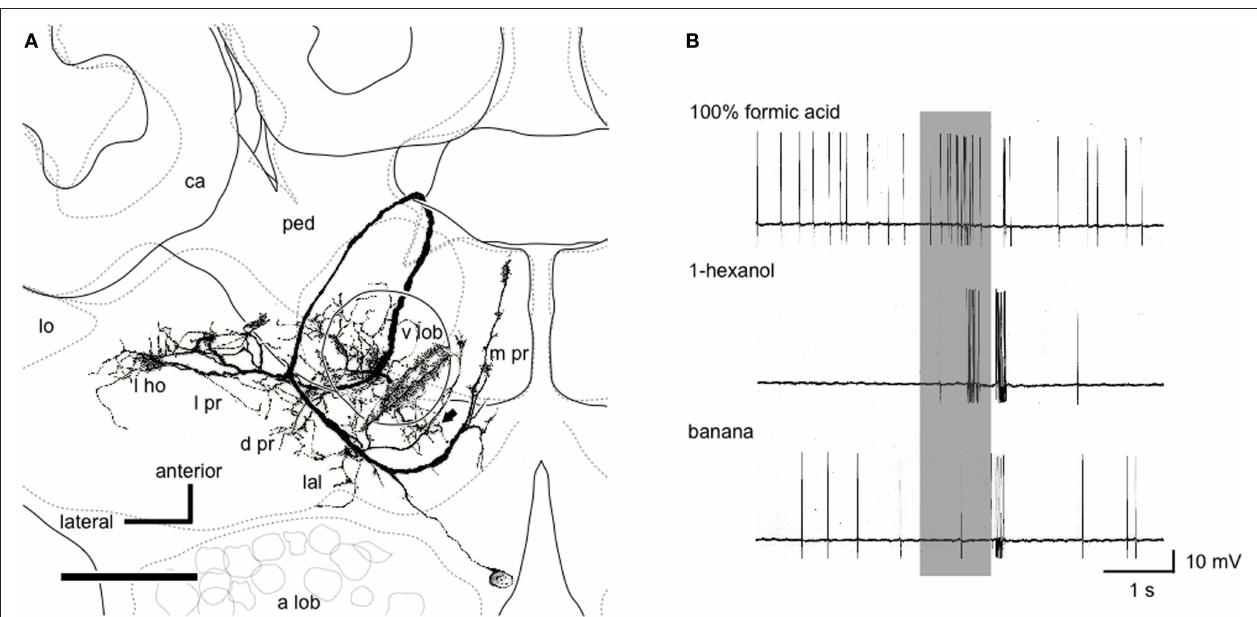
extends terminal arbors in the lateral protocerebrum (l pr) and the dorsal protocerebrum (d pr). One axon descends toward the subesophageal ganglion (arrow). For other abbreviations, see legend of Figure 1 . Scale bar = 100 μm. (B) Responses to formic acid, 1-hexanol and banana odor. Application of